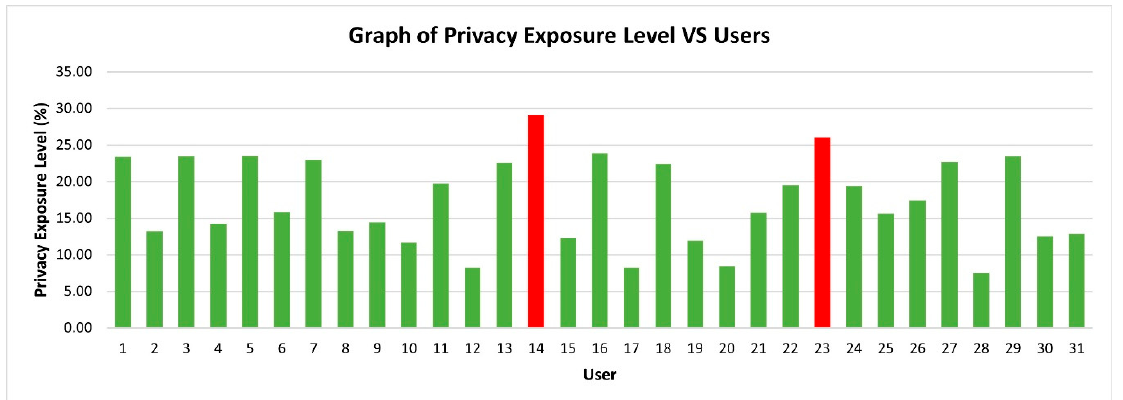
Figure 8. Privacy exposure level vs. users.